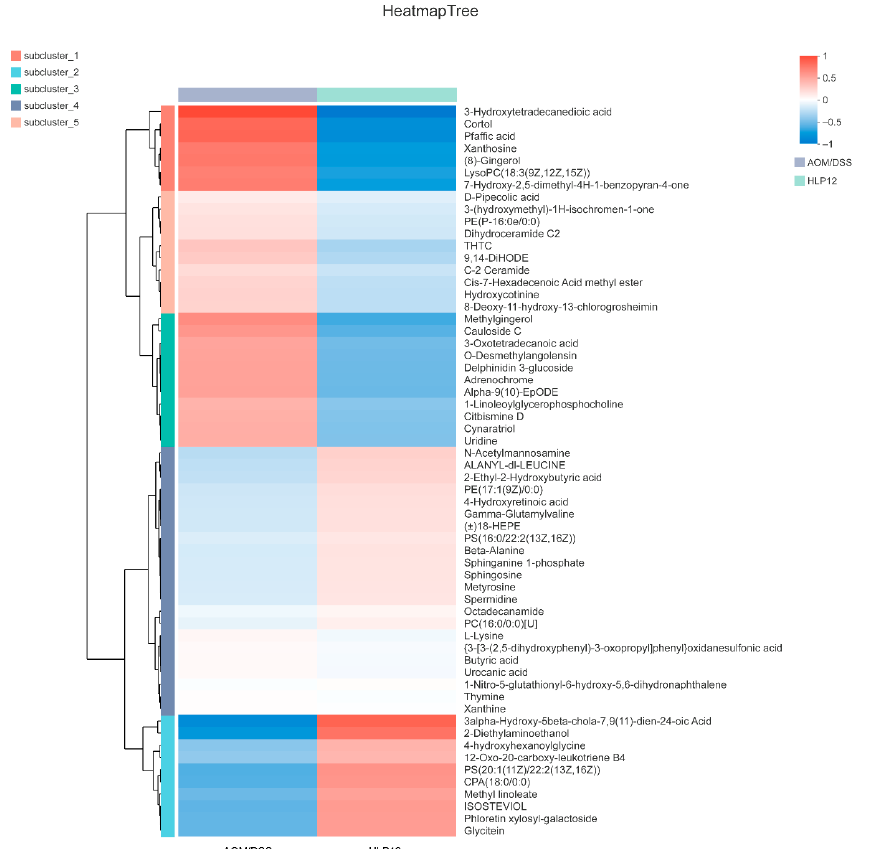
Figure 13. Metabolite cluster analysis of the AOM/DSS-treated C57BL/6 mice in AOM/DSS and HLP12 groups ( n = 5).